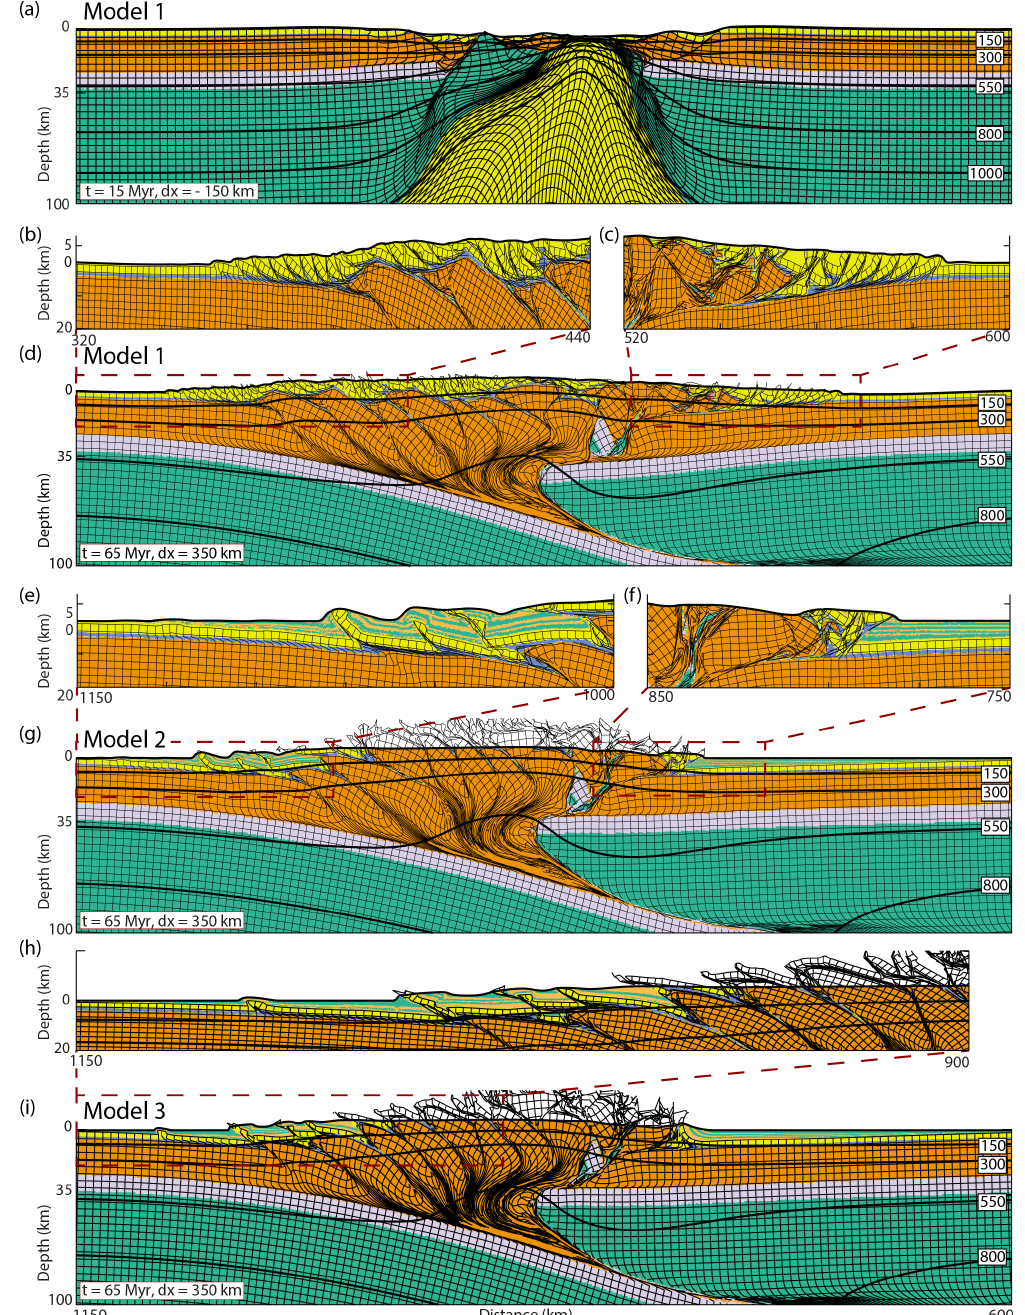
Figure 3. Model results. The material coloring scheme is identical to that used in Fig. 2. All models are run for 65Myr: 15Myr (150km) extension followed by 50Myr (500km) contraction for a total net contraction of 350km. The horizontal scale for panels (a) , (d) , and (g) is the same as that of panel (i) . (a–d) Model 1 with no surface processes, showing deformed Lagrangian mesh and isotherms after (a) 15Myr ( (cid:49)x = − 150km) and (d) 65Myr ( (cid:49)x = 350km). Panels (b) and (c) are extracts from panel (d) showing the small-scale deformation patterns in the foreland fold-and-thrust belts. (e–g) Model 2 including a simple surface-process algorithm filling up accommodation space until a base level of − 500m, showing deformed Lagrangian mesh and isotherms after 65Myr ( (cid:49)x = 350km). Panels (e) and (f) are extracts from panel (g) showing the small-scale deformation patterns in the foreland fold-and-thrust belts. (h–i) Model 3 including a simple surface- process algorithm with the sedimentation base level changing from − 500 to 0m at t = 45Myr. Panels show deformed Lagrangian mesh and isotherms after 65Myr ( (cid:49)x = 350km). (h) An extract from (i) showing the small-scale deformation patterns in the pro-wedge foreland fold-and-thrust belt. Note that the polarity of subduction is randomly oriented for each model. For ease of comparison we flipped Models 2 and 3 to show them in the orientation that is conventional for the Alpine cross